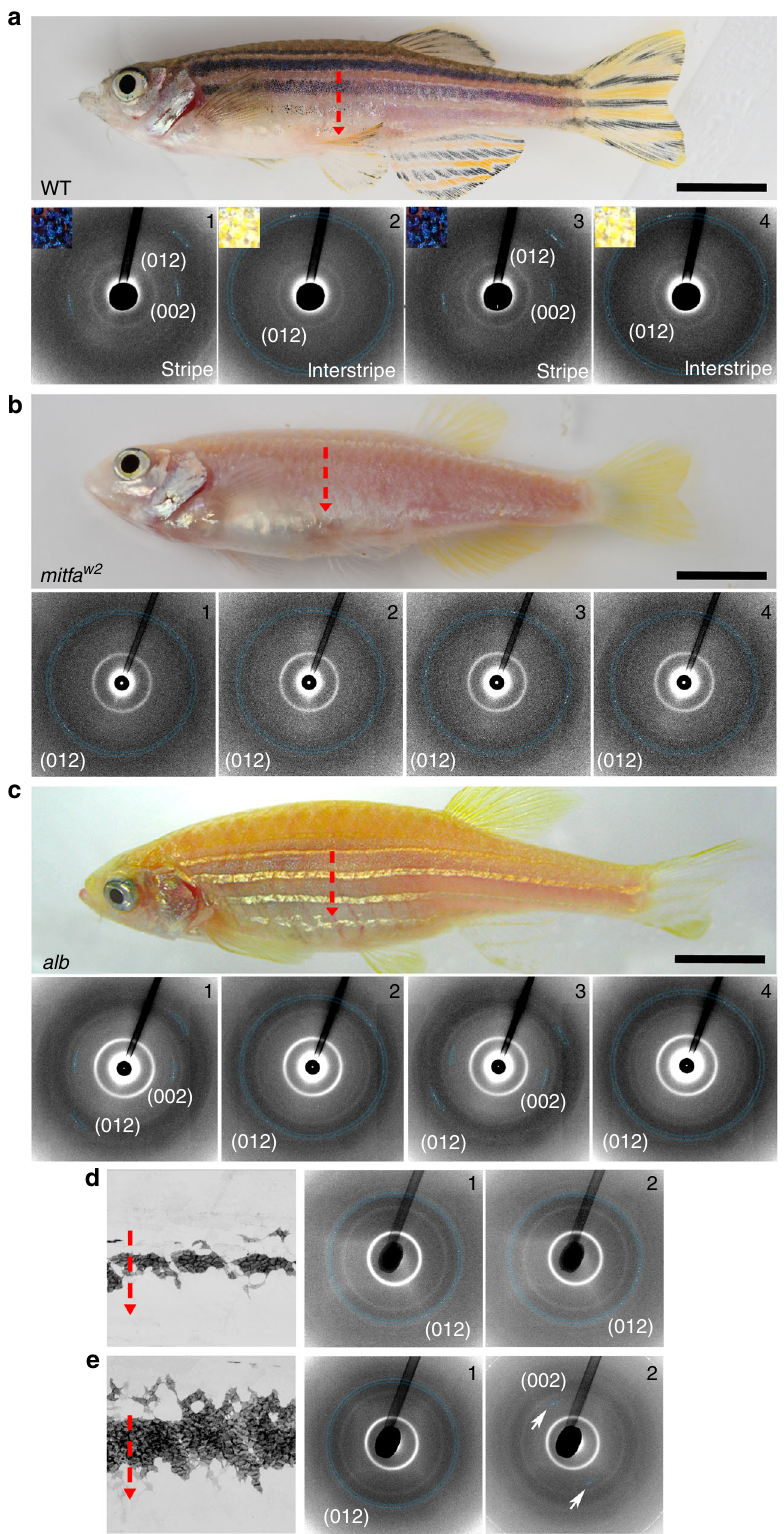
(interstripe) iridophores invading the stripe regions 19 . In line with these fi ndings, we found that tjp1a is highly expressed in cluster c3 (mostly interstripe iridophores) and expressed at lower levels in cluster c5 (mostly stripe iridophores). Other